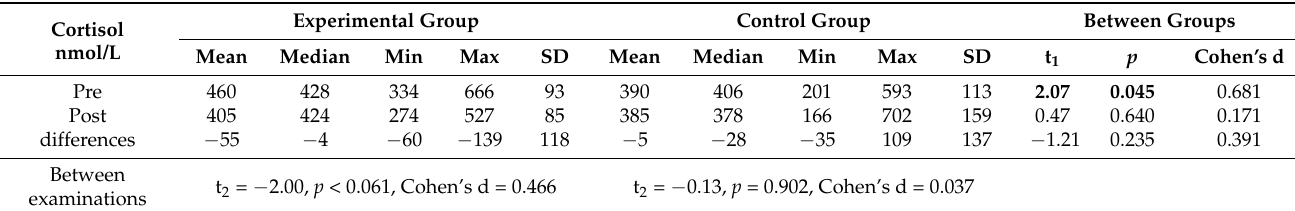
Between examinations